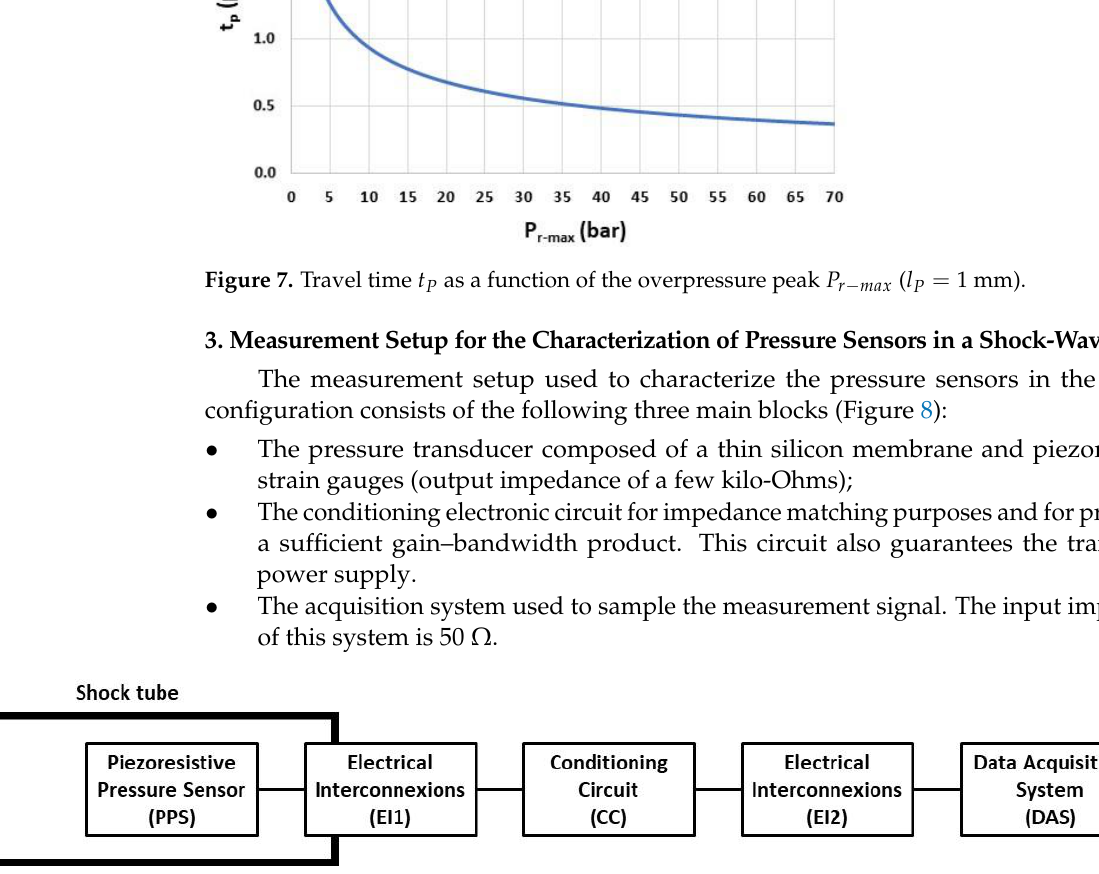
Figure 8. Diagram of the measurement setup used for the shock-wave tube characterization of a pressure sensor.